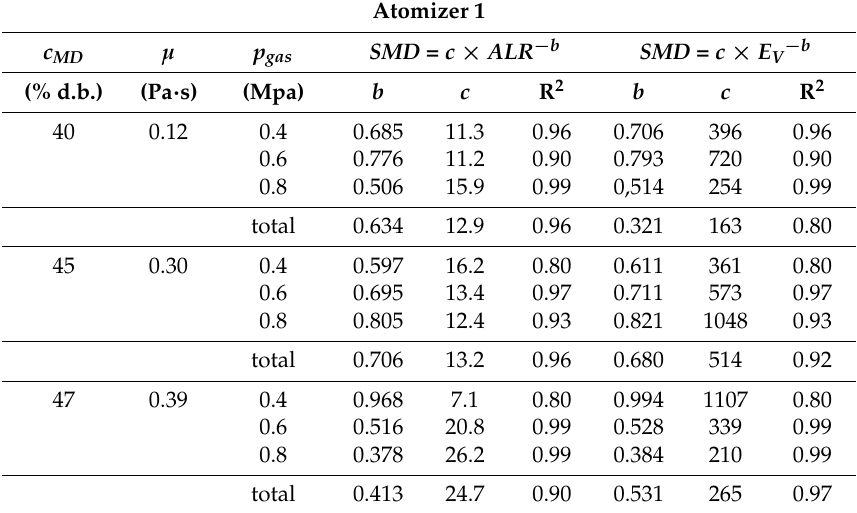
Table 4. Fit parameters b and c , as well as determination coefficient R 2 for correlations between Sauter mean diameter (SMD) and ALR, as well as between SMD and E V